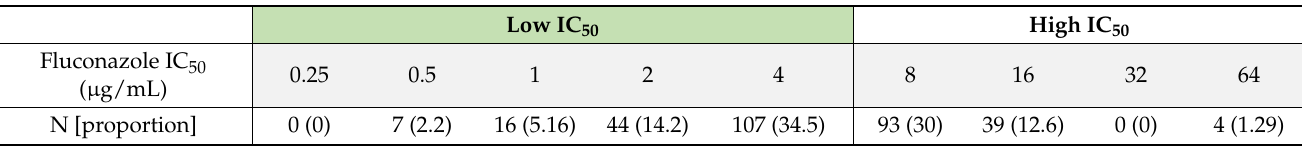
Table 1. C. neoformans clinical Isolates Fluconazole IC 50 .